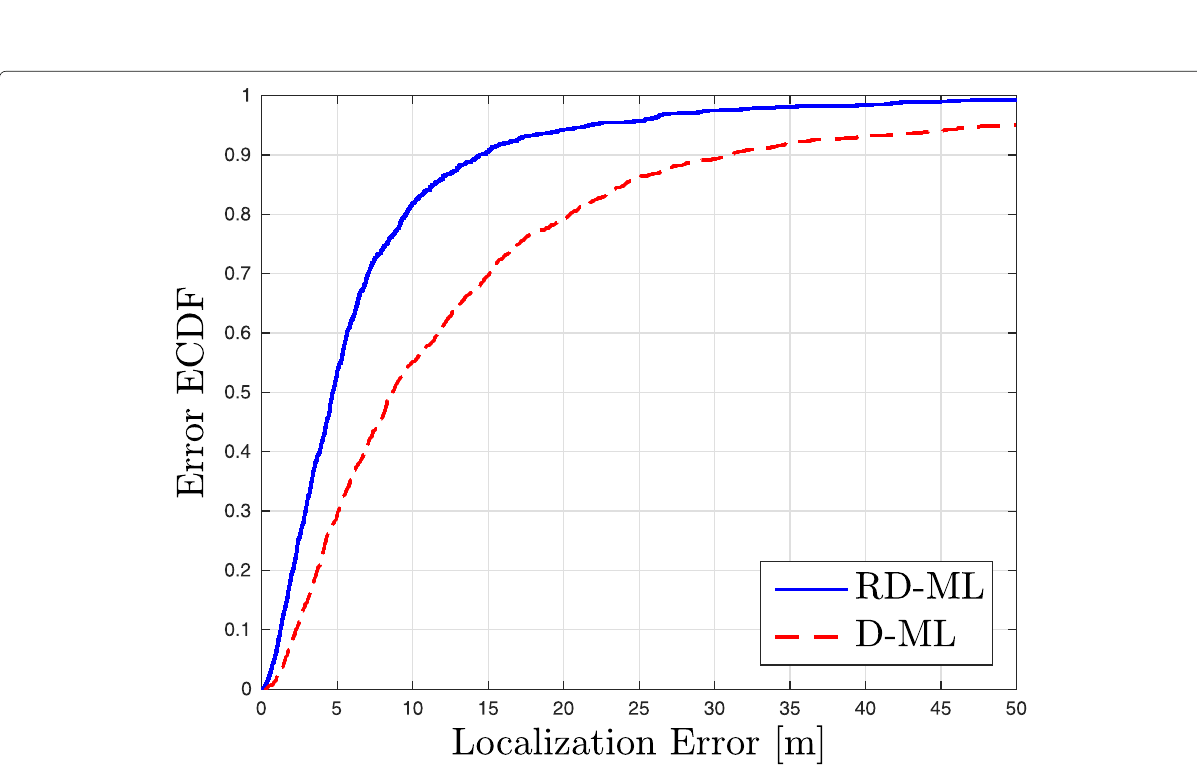
Fig. 7 Mixed LoS/NLoS scenario with Student’s t distributed noise with ν = 5 under NLoS. Fully connected networks, randomized NLoS fraction, N a = 11, N u =